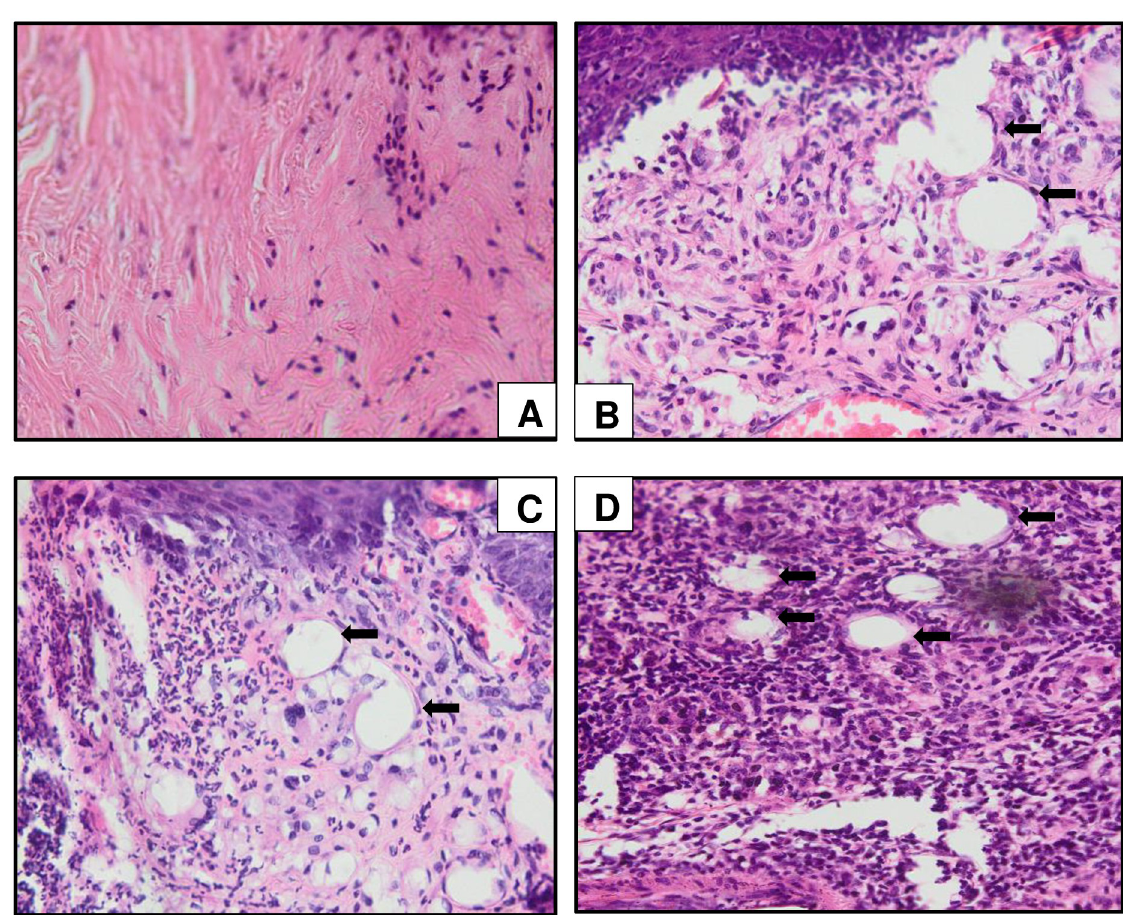
Fig 8. Histological sections of the CFA-inoculated hind paw tissues in (A) control, (B) CFA 5.0, (C) CFA 7.5 and (D) CFA 10.0 subjected to haematoxylin and eosin (H&E) staining at 400x magnification. The control group demonstrated no significant lesion appearance in the mineral oil-injected hind paw. Meanwhile, extensive inflammatory cells infiltration was observed in CFA 10.0 group, (D) mild and moderate level of inflammatory cells infiltration were detected in CFA 5.0 (B) and CFA 7.5 (C), respectively. The arrow indicates the extensive inflammatory cells infiltration at the injected hind paw